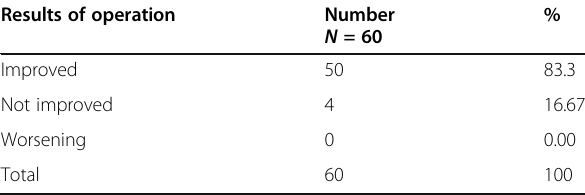
Table 6 The operation results of patient with nasal obstruction Results of